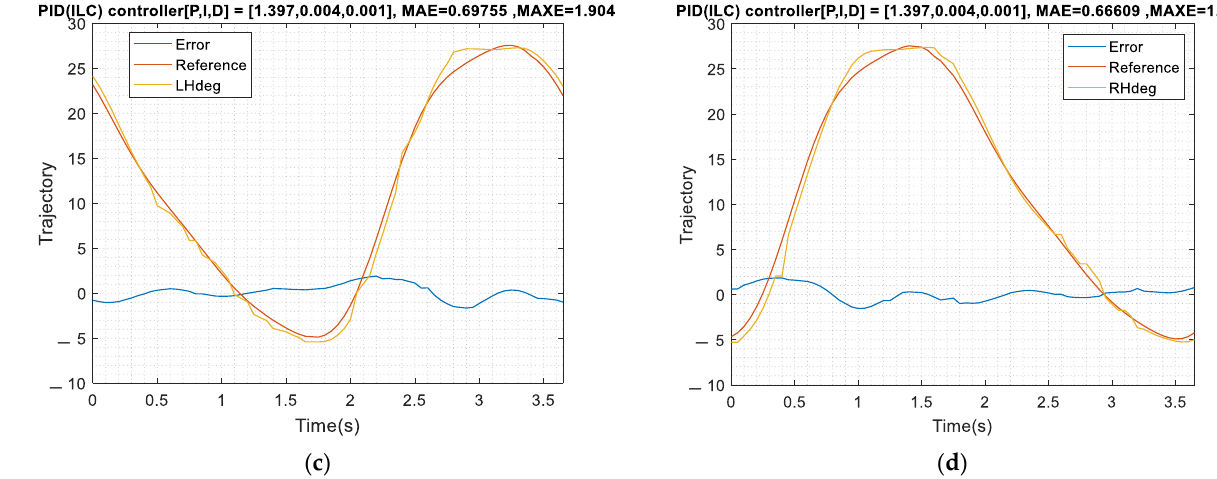
Figure 25. Subject P2 data. ( a ) Left knee tracking results; ( b ) right knee tracking results; ( c ) left hip tracking results; ( d ) right hip tracking results. Table 7. Rehabilitation controller performance data for 10 subjects.